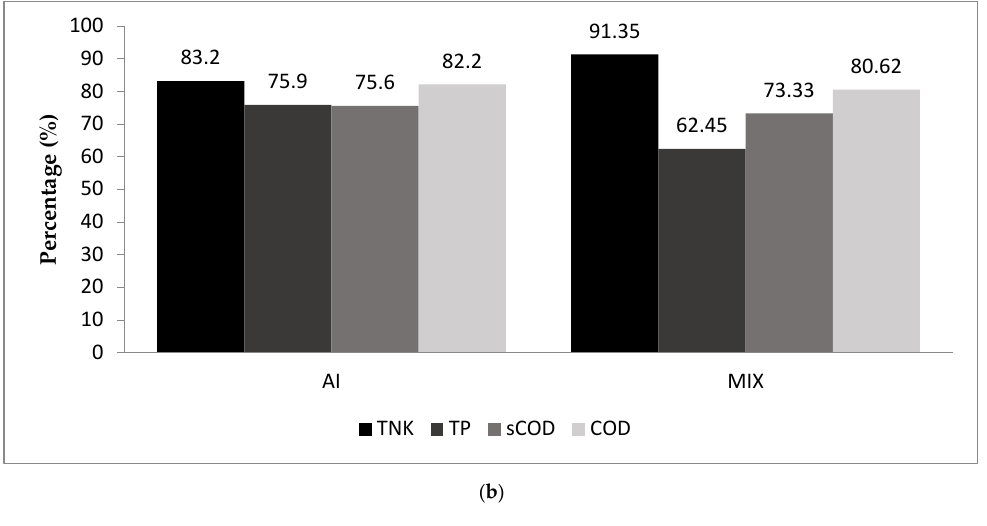
Figure 4. Removal rate for AI and MIX processes, with feeding at night. ( a ) (NH 4 + ) and (PO 43 − ) removal for AI/MIX. ( b ) TNK, TP, sCOD, and COD removal for 48 h under AI/MIX.